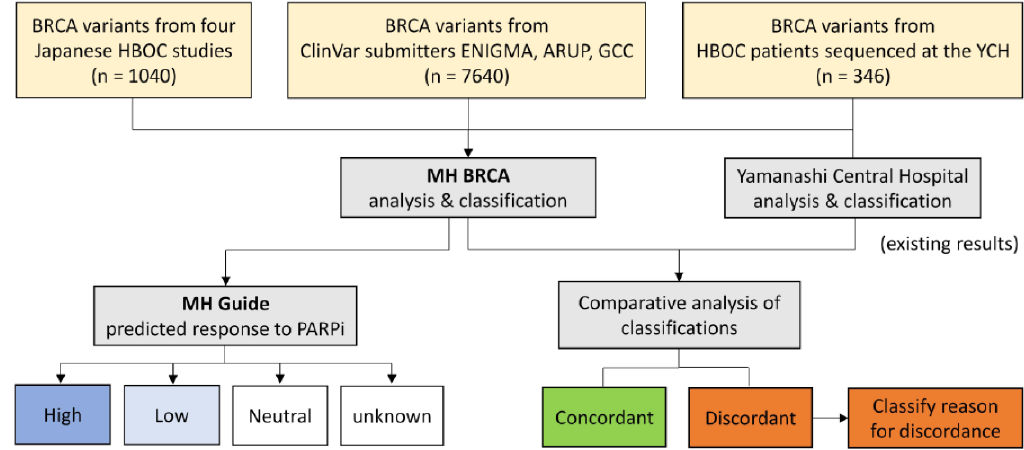
Figure 1. Study design for the validation of MH BRCA. BRCA1 / 2 variants from Japanese HBOC studies of Arai et al. [12], Hirotsu et al. [13], and Nakagomi et al. [14] were compared to ACMG-guided classifications in MH BRCA with or without the Japanese genomic cohort data of ToMMo. The study of Momozawa et al. [15] was compared to a consolidated interpretation based on the database consensus classification and the ACMG-guided calculation provided by MH BRCA. Further, datasets of ClinVar submitters ENIGMA, ARUP, and the German Cancer Consortium were used to evaluate the ACMG classification of MH BRCA. Finally, we compared our clinically assessed BRCA1 / 2 classifications from HBOC-related cancer patients sequenced at the Yamanashi Central Hospital. Comparative analysis in each dataset determined the concordance-rate and the reason of discordance. The datasets of our patient cohort and the examined Japanese HBOC studies were analyzed for predicted treatment response to PARP inhibition in MH Guide. Results were correlated to the corresponding BRCA1 / 2 variant classification by MH BRCA.